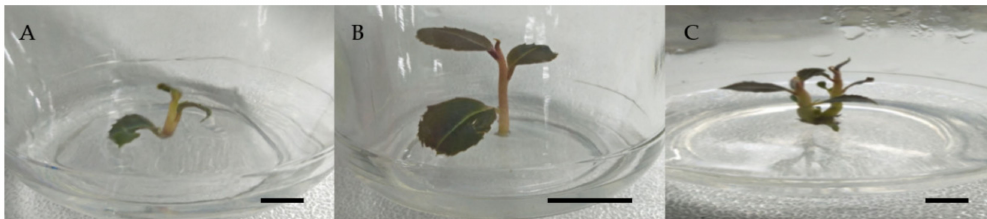
Figure 1. The effect of different concentrations of zeatin on growth of Labisia pumila var. alata compared to the control after 6 weeks of culture. ( A ) Stunted growth (4 mg/L zeatin), ( B ) healthy growth (2 mg/L zeatin), and ( C ) control treatment. Horizontal bar = 1